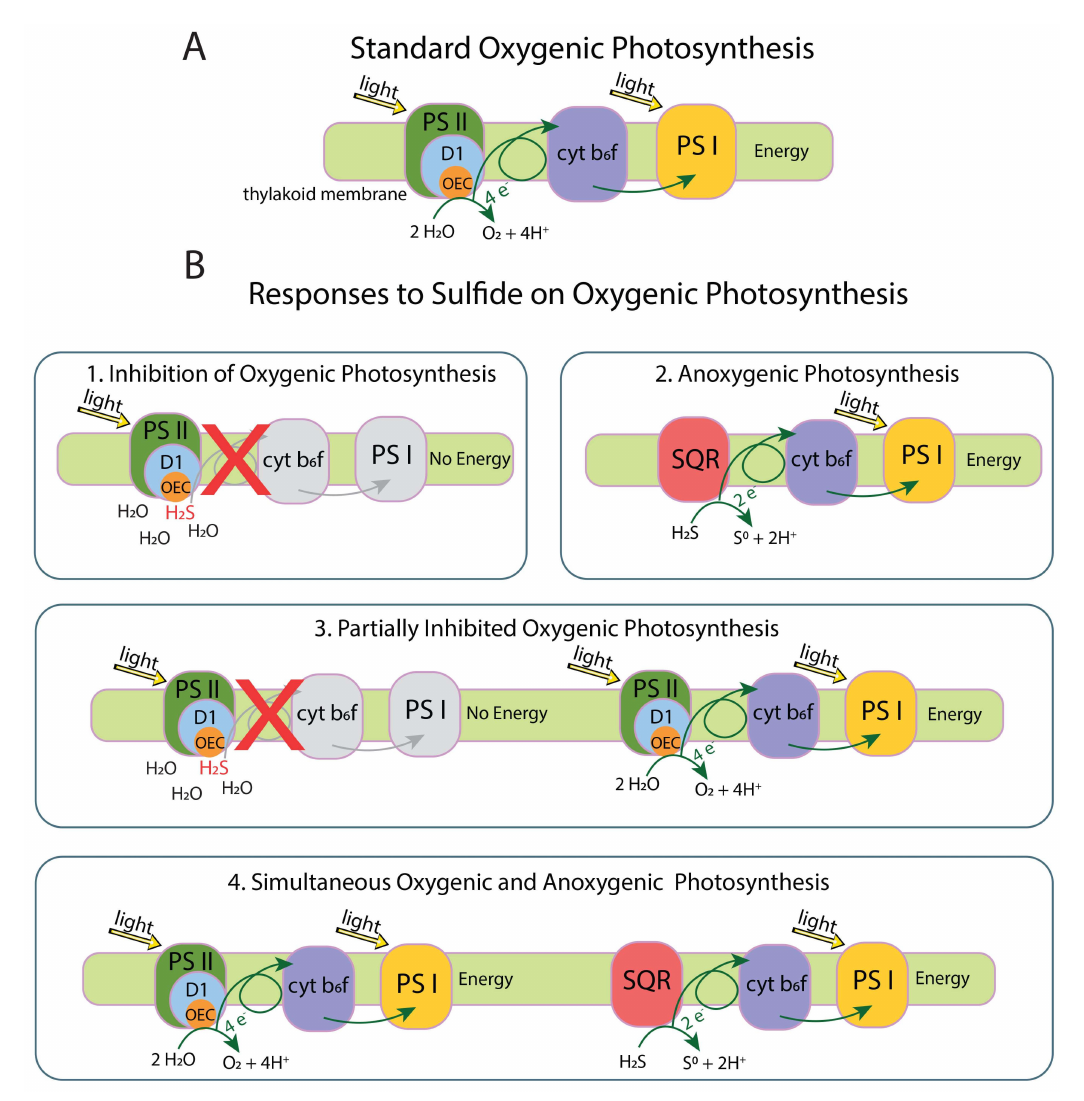
Figure 1. ( A ) standard electron flow in oxygenic photosynthesis. ( B1 ) inhibition of oxygenic photosynthesis (OP) by sulfide blocking the oxygen-evolving complex (OEC) in the D1 protein, prohibiting H 2 O from interacting with the OEC and from electrons to flow through the system. ( B2 ) anoxygenic photosynthesis (AP) occurs when sulfide quinone reductase (SQR) extracts electrons from sulfide and passes them along the photosynthetic electron transport chain. Sulfide is oxidized to S 0 , which does not interact with the OEC. ( B3 ) partially inhibited OP occurs when some D1 proteins are blocked by sulfide while others extract electrons from H 2 O and pass them along to carry out OP. Excess O 2 produced from OP will oxidize sulfide to sulfate, removing sulfide from the environment. Some cyanobacteria increase psbA expression to replace the D1 protein in response to stress, which may support this response. ( B4 ) some cyanobacteria can do OP and AP at the same time, or alternate between the two processes, until sulfide is fully depleted. Oxygenic photosynthesis protein complex image modified from the Kyoto Encyclopedia of Genes and Genomes (KEGG)